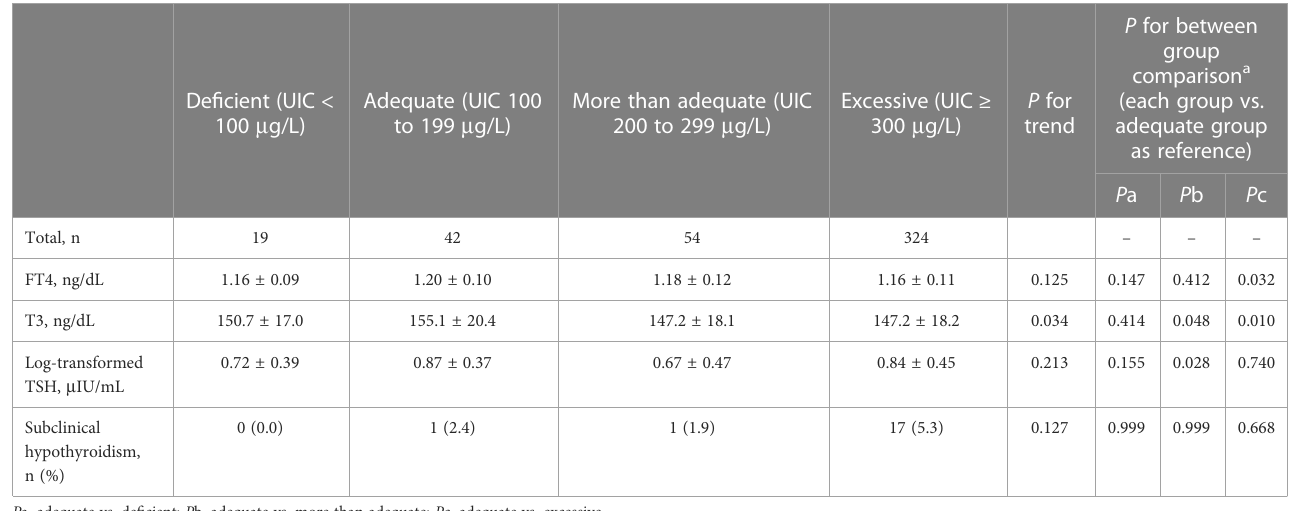
TABLE 2 Thyroid function status according to iodine